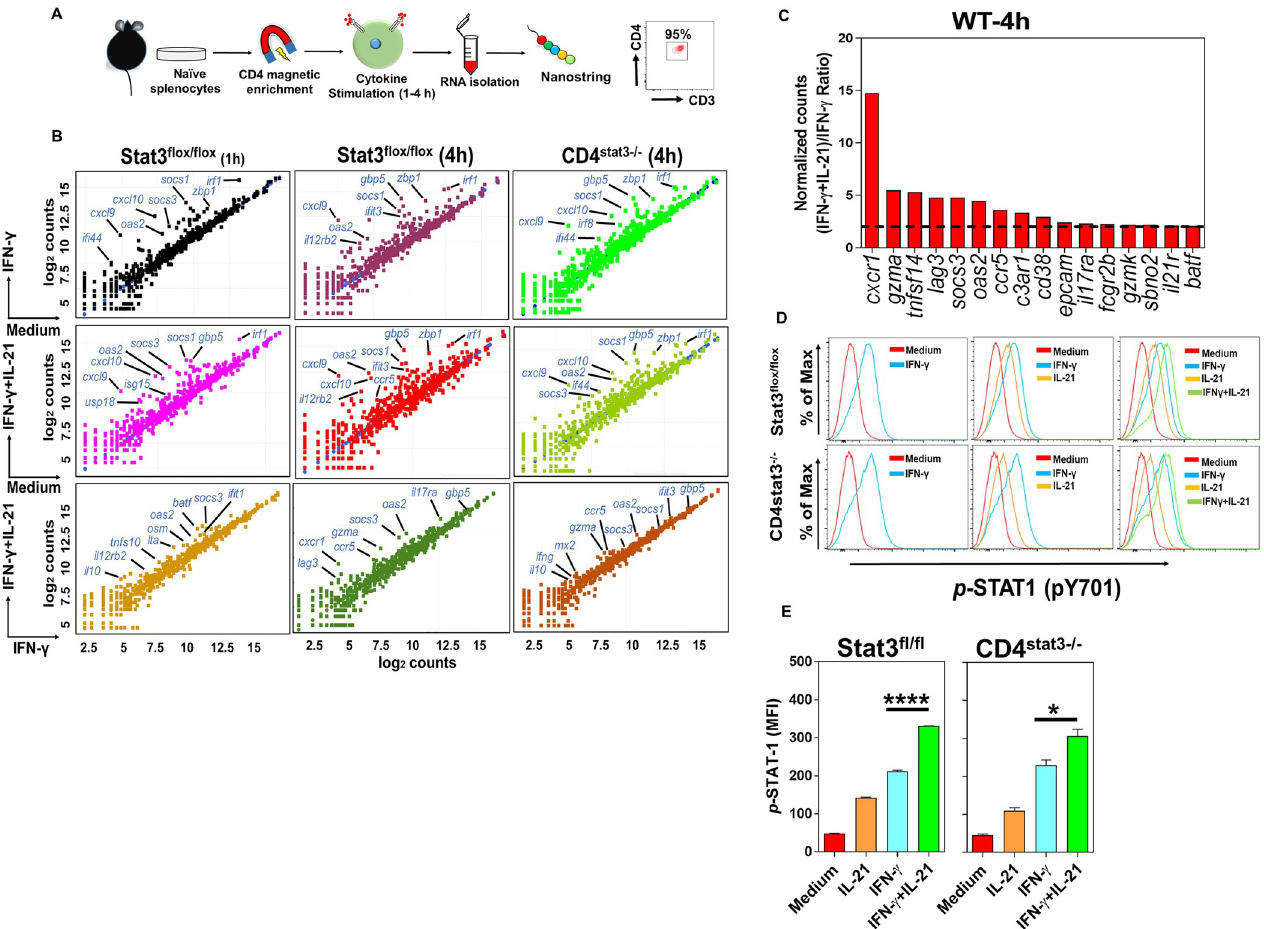
Fig 7. STAT3 signaling is not required for the optimal expression of ISGs by IL-21 and IFN- γ collaboration in CD4 + T cells. A . Experimental setup and cell purity after CD4 + T cell negative selection. B . Scatter plot representation (log 2 values) of gene expression signatures in pooled purified na ï ve CD4 + T cells from STAT3 flox/flox ( n = 7) or CD4 stat3-/- ( n = 5) mice after treatment with rmIFN- γ or rmIFN- γ +IL-21 vs. medium (top and middle row, respectively) or rmIFN- γ plus rmIL-21 vs. rmIFN- γ alone (bottom row; 20 ng/ml of each cytokine) for 1–4 hr. Purified cells receiving no cytokines were used as controls. C . Histogram shows fold increase of genes in rank order in WT CD4 + T cells following stimulation with single or dual cytokines. Genes with fold difference � 2 between (IFN- γ +IL-21)/IFN- γ were considered. D . Flow cytometric analysis and E . MFI measurements of phosphorylated ( p -) STAT1 ( p Y701) in CD4 + T cells isolated from STAT3 flox/flox (top row) and CD4 stat3-/- (bottom row) mice in the presence of mIFN- γ (20 ng/ml) or mIL-21 (20 ng/ml) alone or in combination (20 ng/ml of each cytokine) for 30 min. Cells receiving no cytokine treatments were used as controls (red histograms). The results are the Mean ± SEM of 3 mice per group from one experiment out of two independent experiments. � p < 0.05; ���� p < 0.0001; One-way ANOVA followed by Bonferroni post-hoc adjustment test for multiple